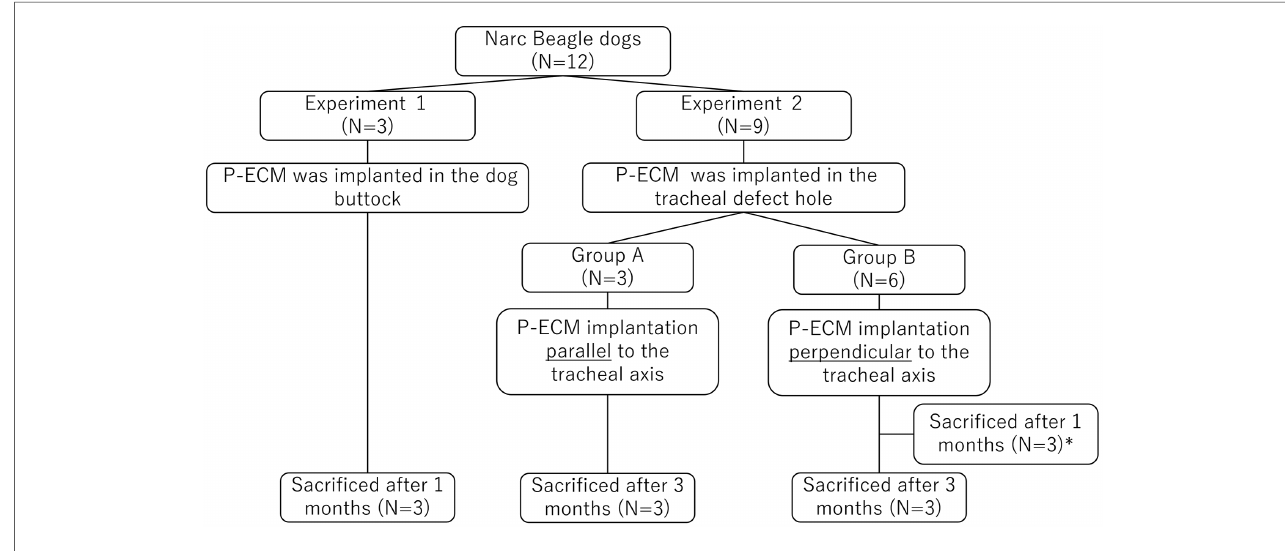
FIGURE 1 Study design fl owchart. *In group B, three dogs were euthanized 1 month after surgery to observe the extent to which epithelialization had